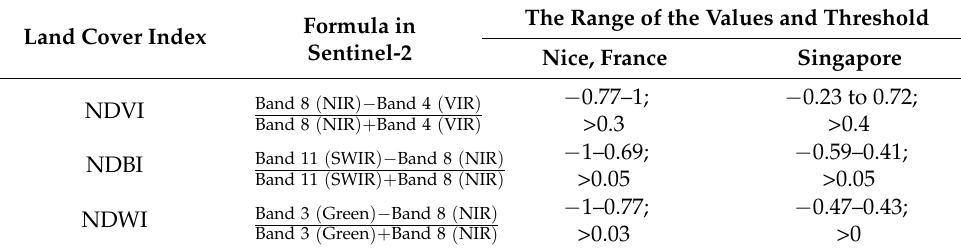
Table 3. The formula of the land cover index and the value of the threshold used in this research. Land Cover